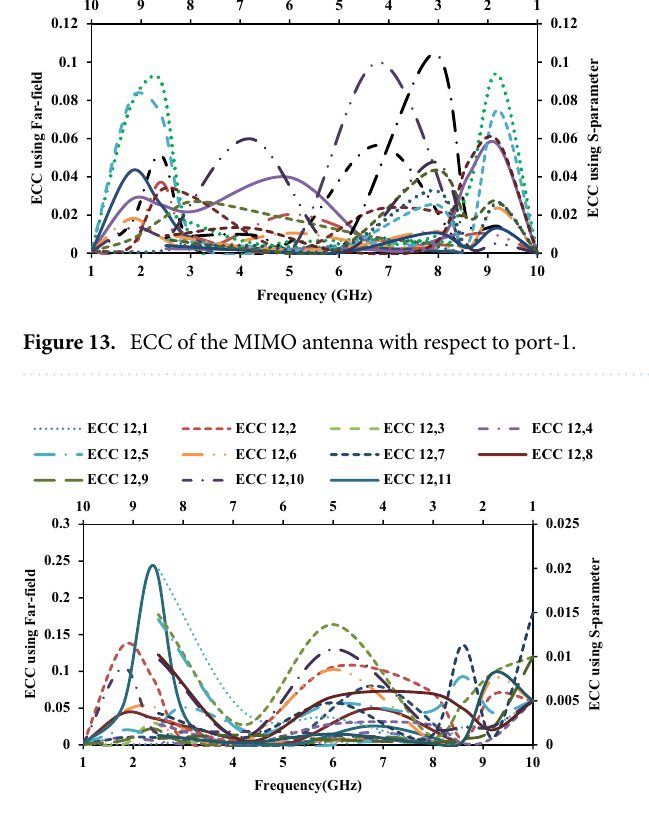
Figure 14. ECC of the MIMO antenna with respect to